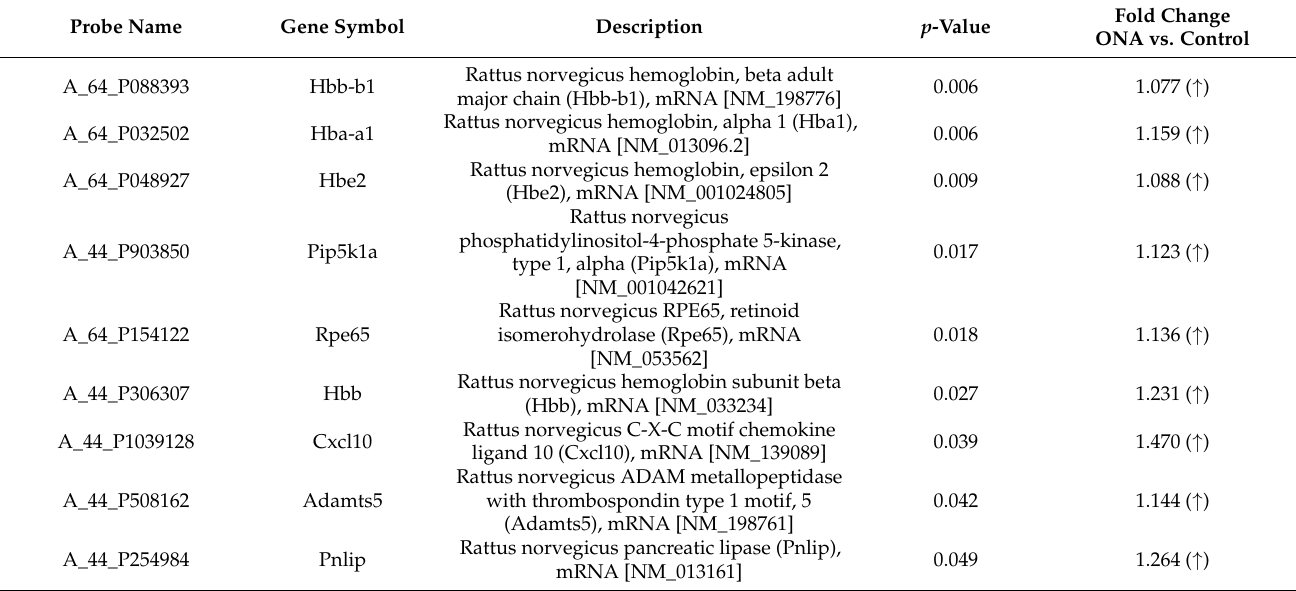
Figure 5. Upregulation of inflammatory cytokines. ( A ) The mRNA expression levels of Il11 tended towards an upregulation after ONA immunization ( p = 0.068). A significant upregulation was noted in the mRNA expression levels of Il18 ( p = 0.029) and Il33 ( p = 0.041) in ONA retinae. ( B ) RT-qPCR analyses of Nfkb1 mRNA levels revealed a significant upregulation in ONA retinae ( p = 0.012). ( C ) Retinae were stained against anti-NF κ B (green), while DAPI (blue) labelled cell nuclei. ( D ) The number of NF κ B + cells were not altered between both groups. Scale bars: 20 µ m. GCL = ganglion cell layer; IPL = inner plexiform layer. Values for RT-qPCR are median ± quartile ± minimum/maximum and values for immunofluorescence are mean ± SEM. The dotted lines in ( A , B ) represent the relative expression of the control group. * p < 0.05. Table 3. Oligonucleotide probes, which were found upregulated in ONA